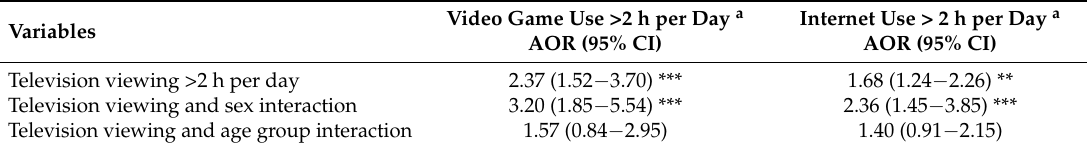
Table 4. Adjusted odds ratios of video game use and Internet use for television viewing >2 h a day.